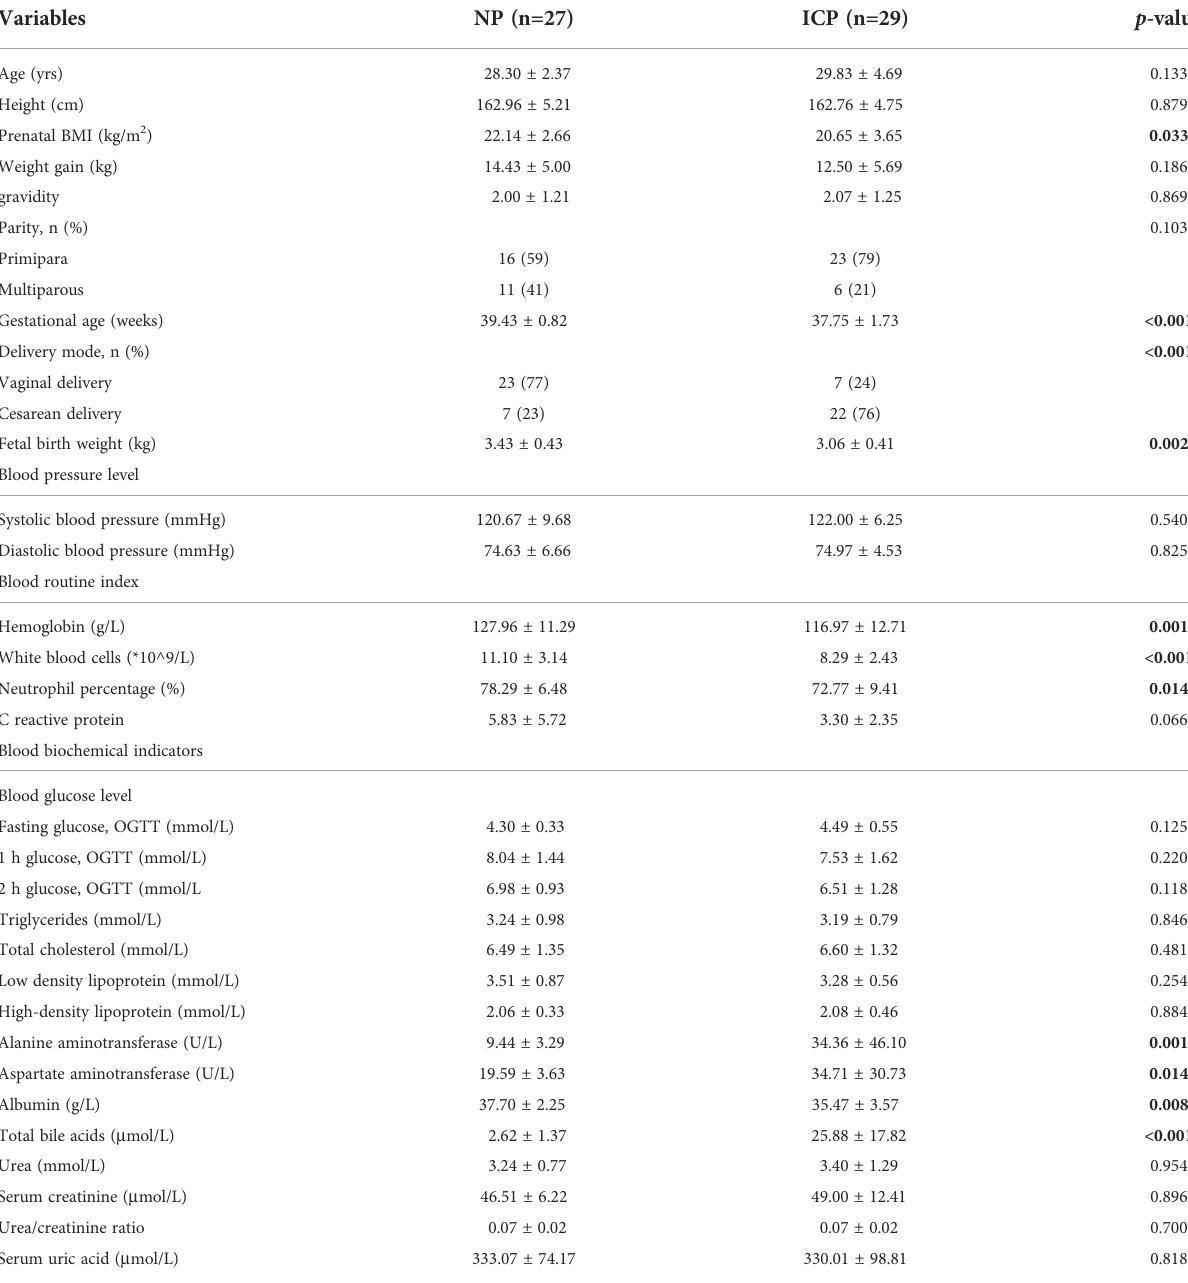
TABLE 3 Maternal and fetal clinical characteristics in the ICP and NP